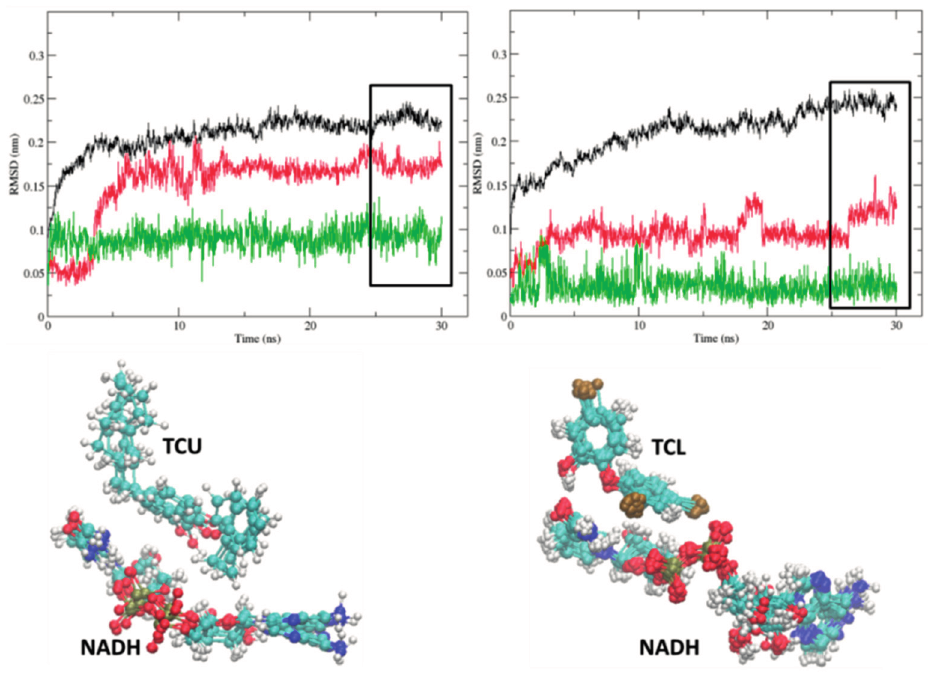
Figure 5. The root-mean-square deviation (RMSD, 1 Å ) of InhA protein (C α -atoms, black line), NADH cofactor (non-hydrogen atoms, green line), and TCU and TCL inhibitors (non-hydrogen atoms, red line) during the MD simulations (Time, ns) of InhA-NADH-TCU (2X23, left) and InhA-NADH-TCL (2B35, right), and on the bottom, the corresponding NADH, TCU, and TCL conformations of the last 5 ns of each